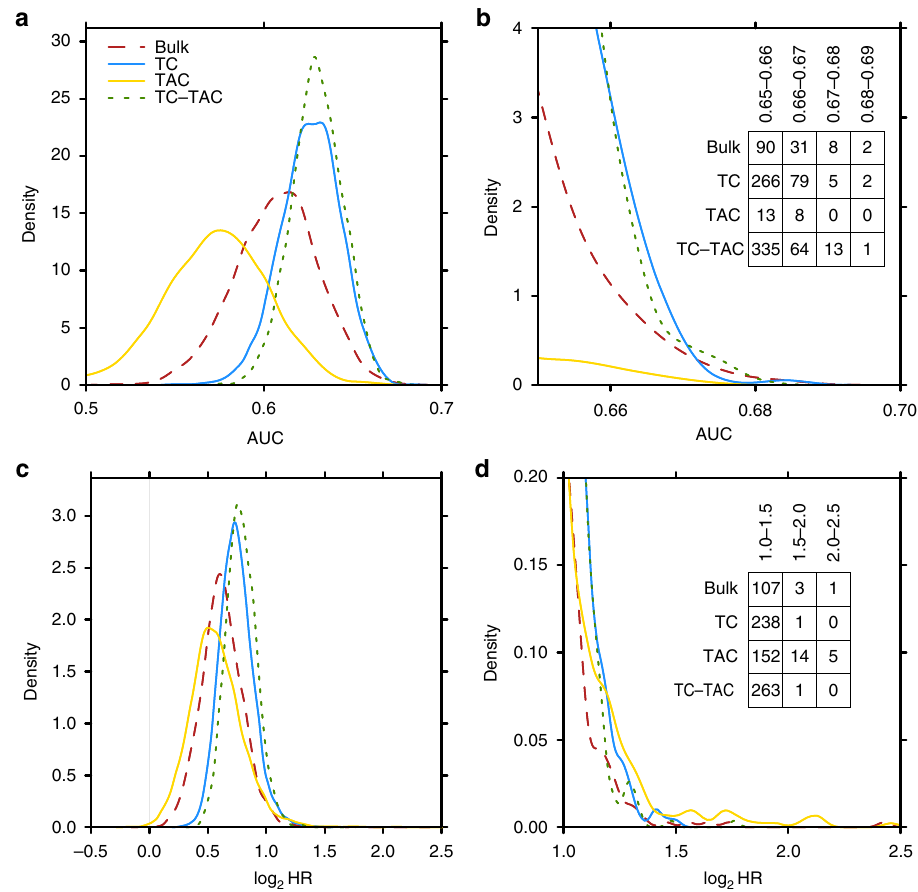
Fig. 5 Biomarker generation. Test set results from biomarkers independently generated on each set of pro fi les. Performance measured using AUC performance ( a ) and log 2 HR ( c ) for 5000 randomly generated biomarkers. Zoom in of the best performing signatures by each metric are shown in b and